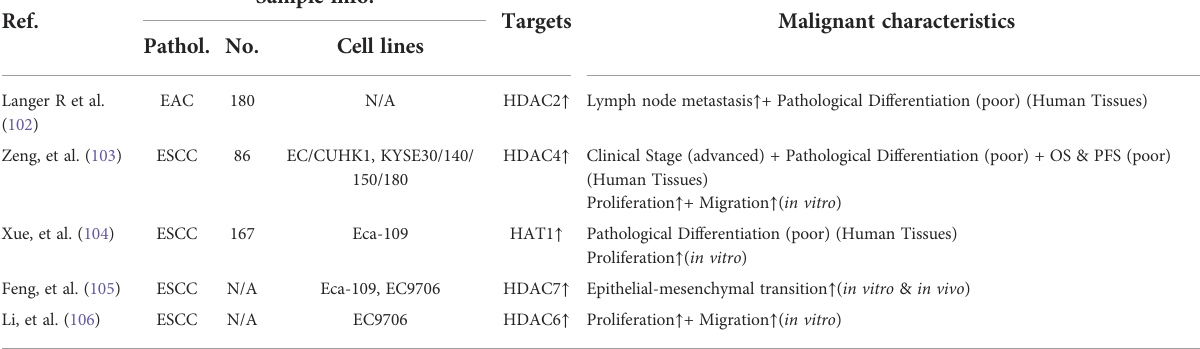
TABLE 2 The correlations between dysregulated HDACs (and/or HATs) and the advanced oncogenic features of esophageal carcinoma.